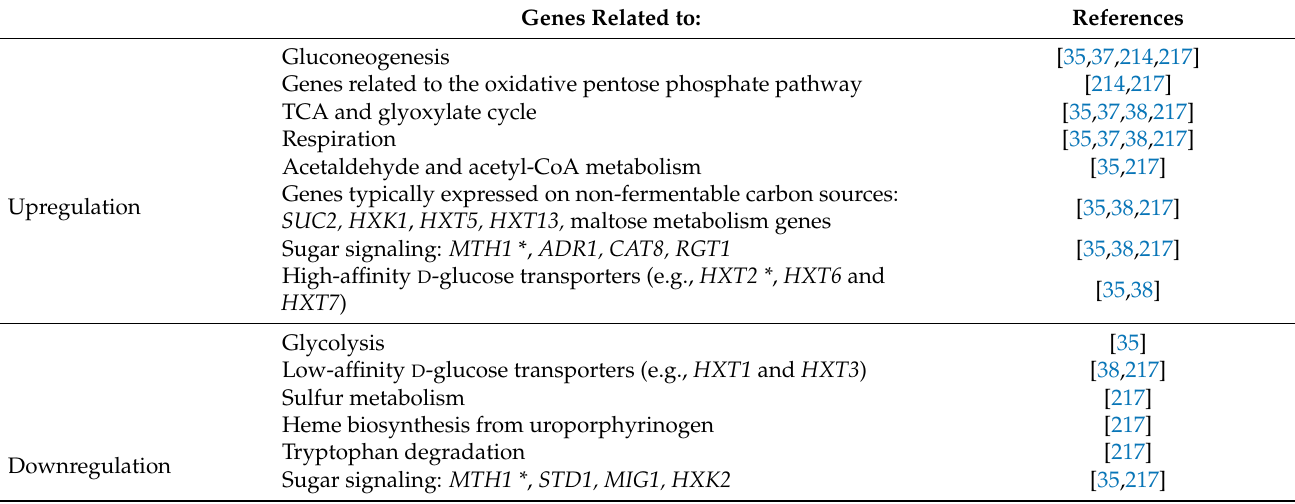
Table 3. Genes found to be upregulated or downregulated in xylose reductase/xylitol dehydrogenase (XR/XDH)strains in the presence of D -xylose. * Note that MTH1 and HXT2 were found to be upregulated and downregulated in different studies. Adapted from